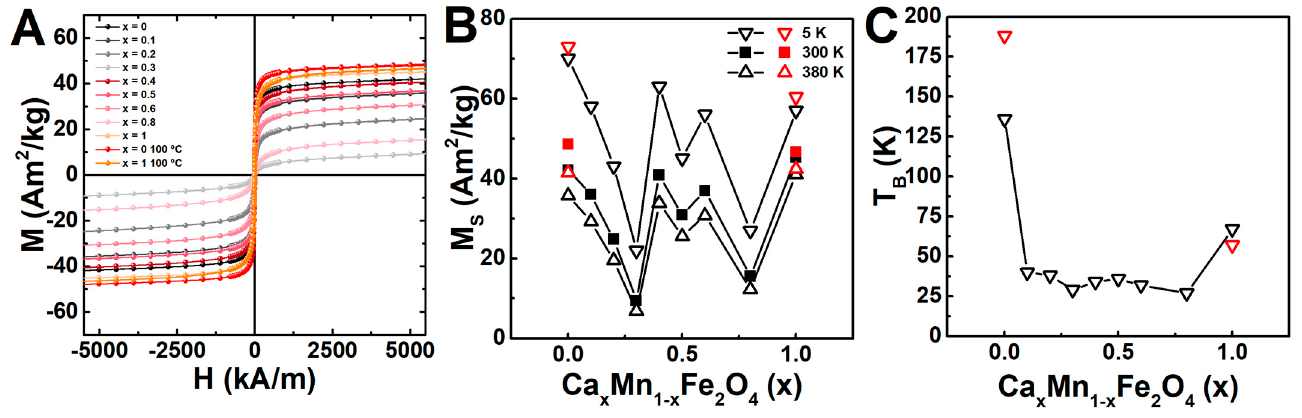
Figure 6. ( A ) Magnetization dependence on the applied magnetic field obtained for the manganese- and/or calcium-doped ferrites obtained at 90 °C (from x = 0 to x = 1) and 100 °C ( x = 0 and x = 1) measured at 300 K. Dependence of the ( B ) saturation magnetization and ( C ) blocking temperature on the Ca/Mn ratio obtained from ZFC and FC curves under a field of 100 Oe.